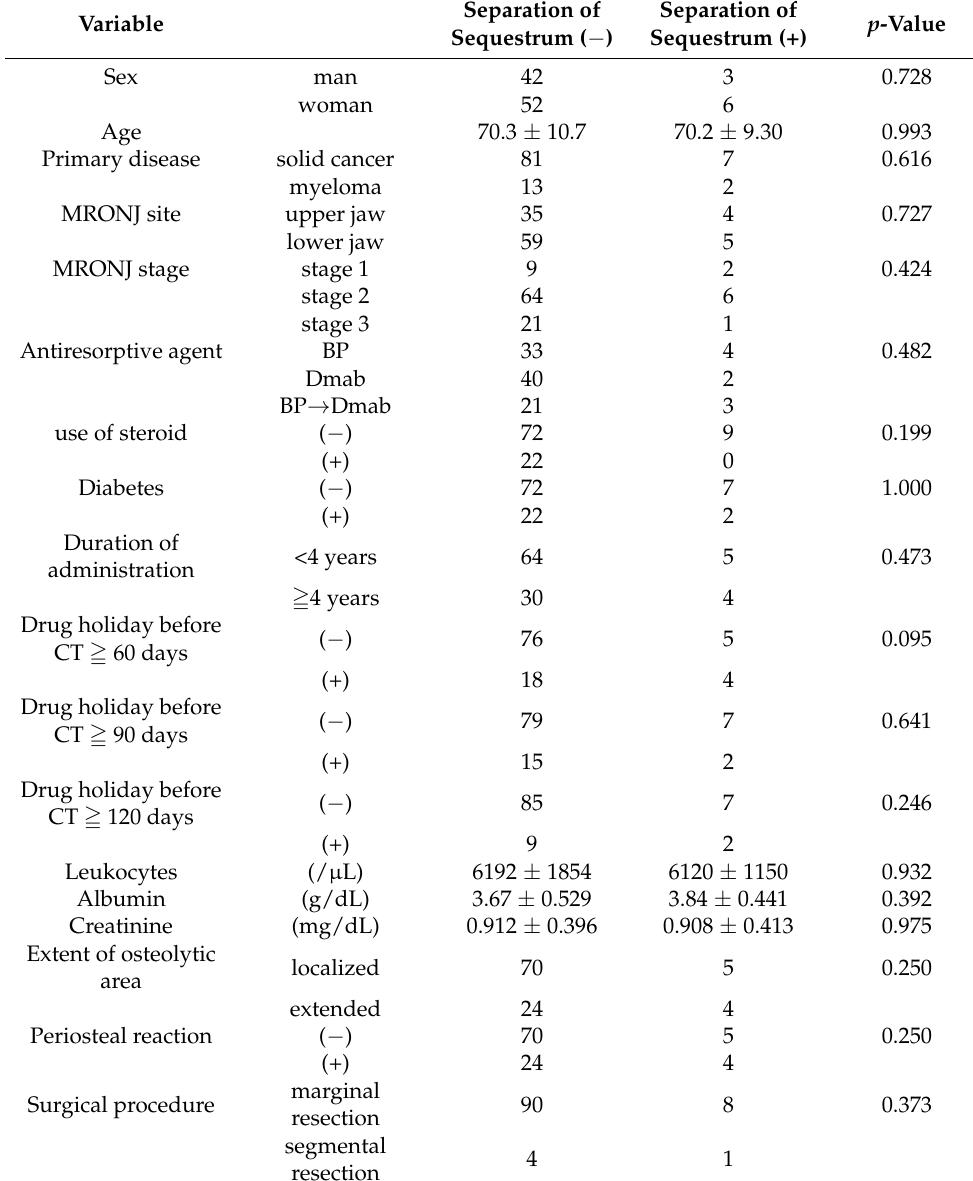
Table 2. Relationship between each variable and sequestrum separation (univariate